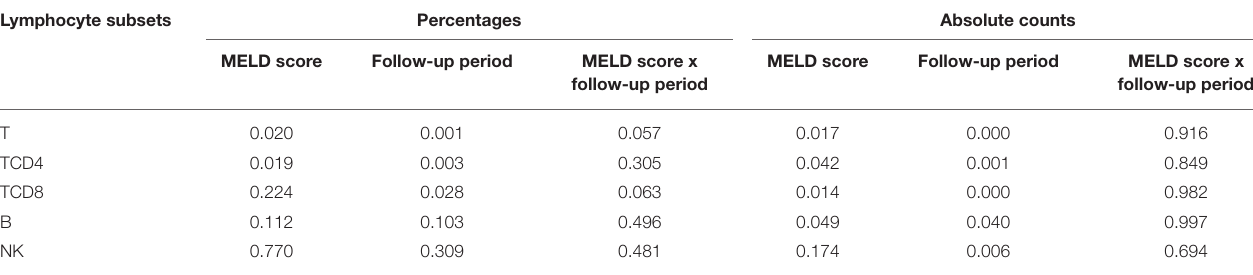
TABLE 4 | The two-way ANOVA for the MELD score, the follow-up period, and the MELD score × the follow-up period interaction. Lymphocyte subsets Percentages Absolute counts MELD score Follow-up period MELD score x MELD score Follow-up period MELD score x follow-up period follow-up